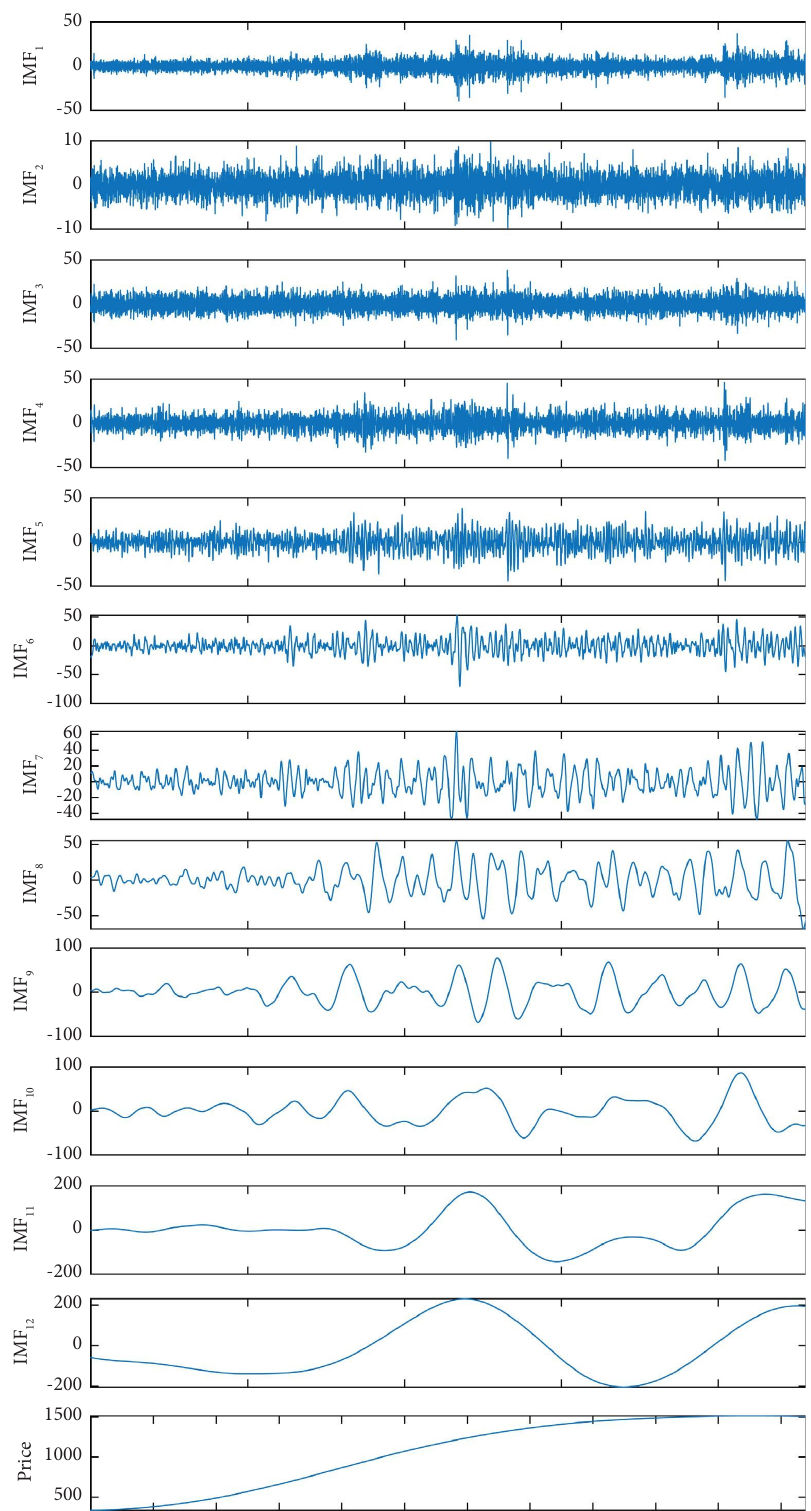
Figure 4: Decomposition of the gold price by CEEMDAN (January 3, 2000–October 21,